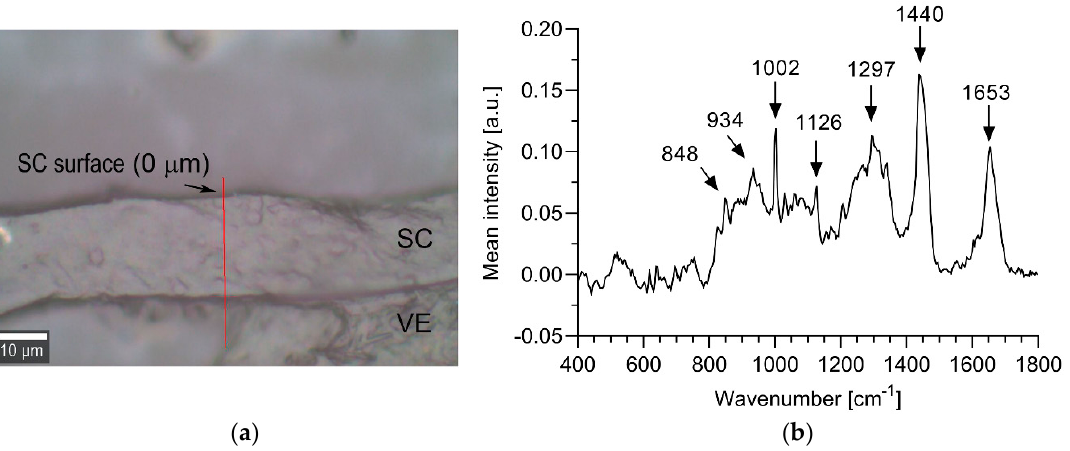
Figure 2. ( a ) White light image of a representative section of EpiSkin™ RHE showing the stratum corneum (SC) and part of the viable epidermis (VE). Spectra were acquired in increments of 2 μ m along the red line. ( b ) Representative spectrum of SC showing major peaks assigned to SC lipids and proteins (see Table 2).